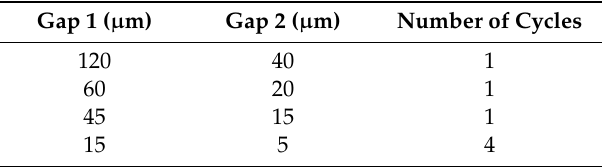
Table 1. Gap distance between rolls during calendering process.